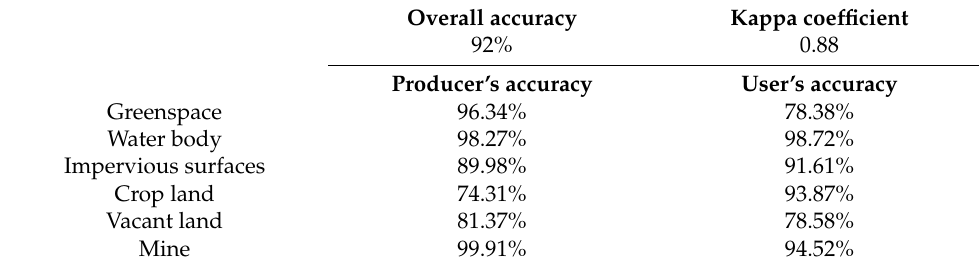
Table 1. The overall accuracy and kappa coefficients for the classification.